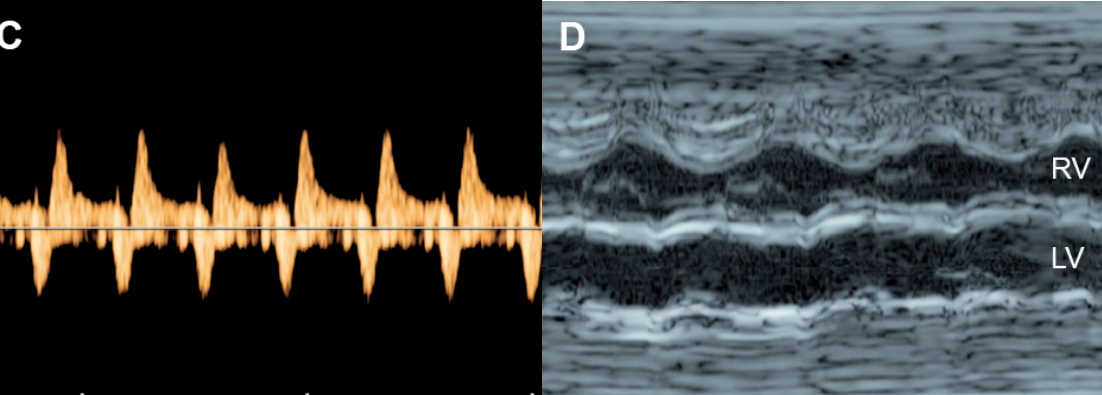
Figure 8. Critical aortic stenosis: ( A , B ) four-chamber views show enlarged LV with echogenic endo- cardium (fibroelastosis), mitral regurgitation, reversed flow across the foramen ovale; ( C ) markedly increased reversed A-wave in the pulmonary vein, indicating high pressure; ( D ) M-mode shows markedly poor contractility of the LV, compared to RV.